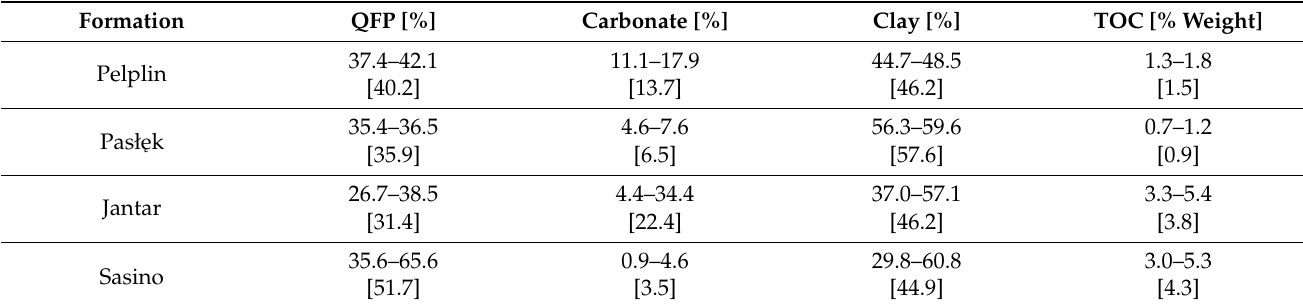
Table 1. Mineral composition and organic matter (TOC) content in the studied siltstone-claystone formations.